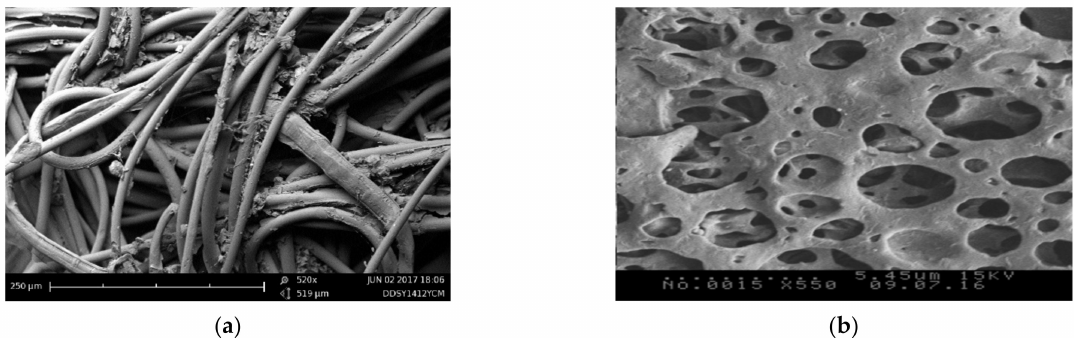
Figure 4. Filter material surface after immersion treatment ( a ) and coating treating ( b ).